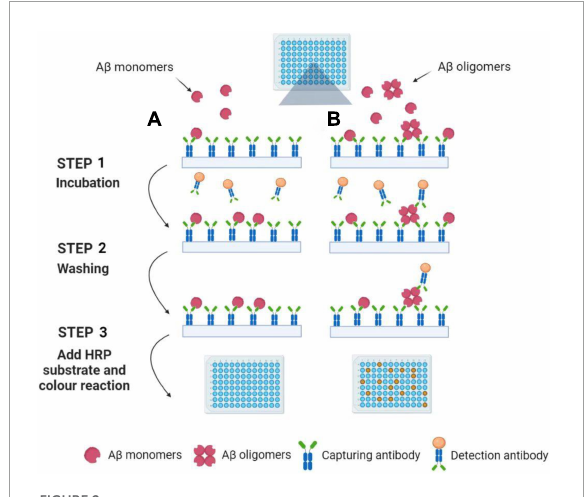
FIGURE2 Detection of A β oligomers using the Multimer Detection System. (A) A β oligomers do not exist in blood plasma samples. A β monomers can be captured by an antibody attached to the ELISA plate’s surface. After incubation and washing, the detection antibodies are not present in the well because the capture antibodies have already occupied the single epitope. Finally, the color reaction can be not observed with the addition of HRP substrate. (B) A β oligomers exist in blood plasma samples. A β monomers and oligomers can be captured by an antibody attached to the ELISA plate’s surface. After incubation and washing, the detection antibodies are still present in the well because the A β oligomers have a lot of epitopes. Finally, the color reaction can be observed with the addition of HRP substrate. Illustrations were generated using